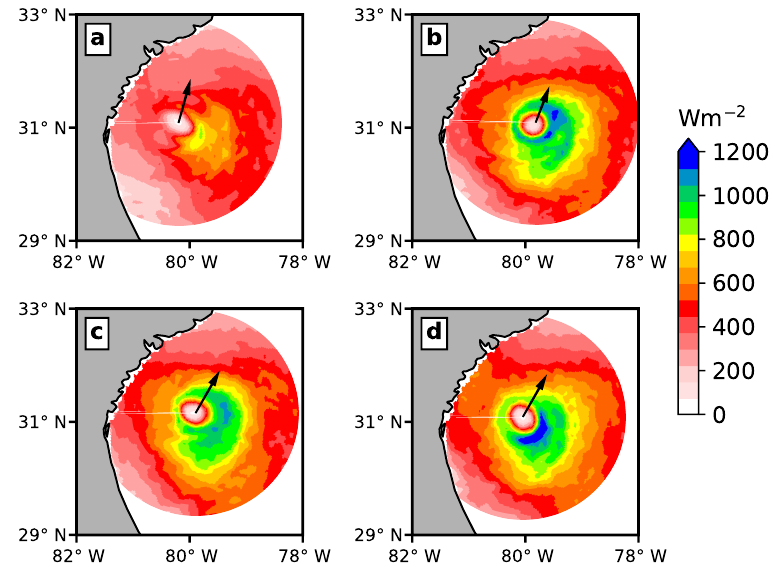
Figure 14. As in Fig. 13, but for the surface latent heat flux.